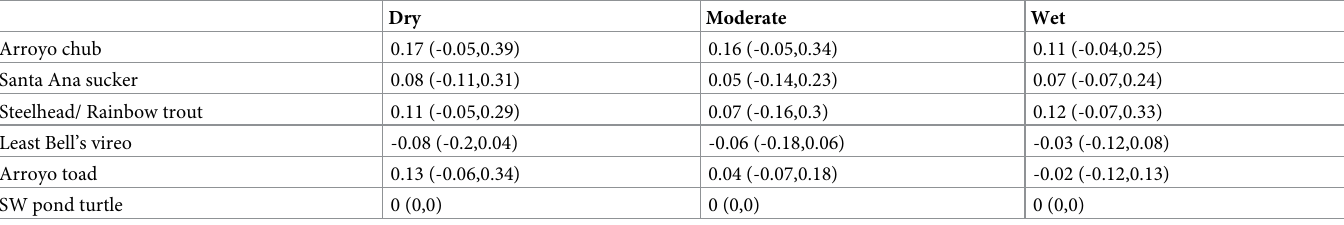
Table 4. The average change probability of occurrence throughout the region due to streamflow metrics from the baseline years to the end-of-century years.